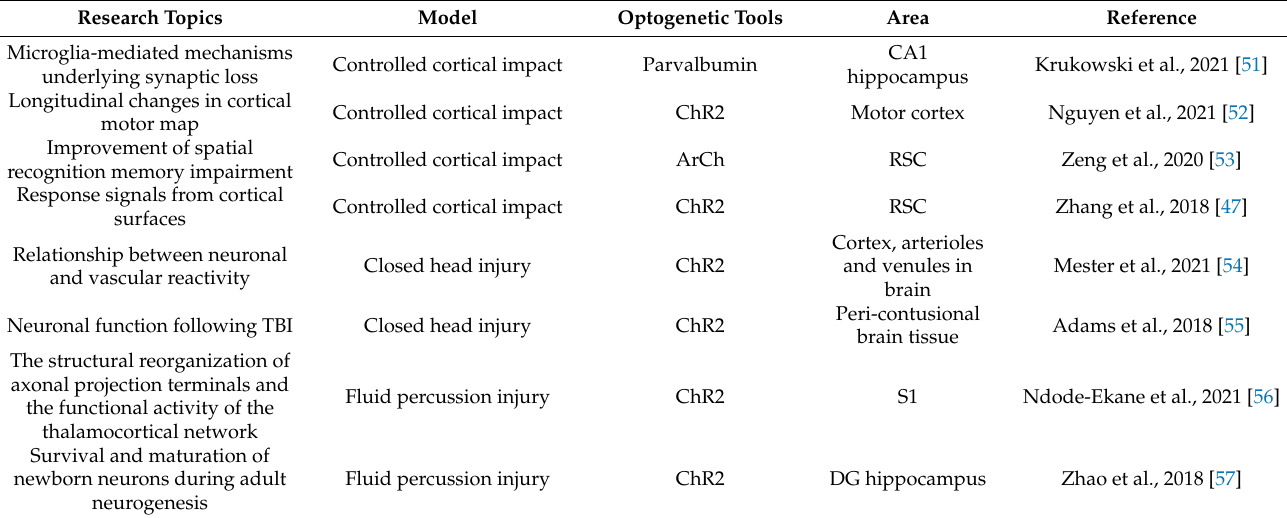
Table 2. Optogenetic TBI